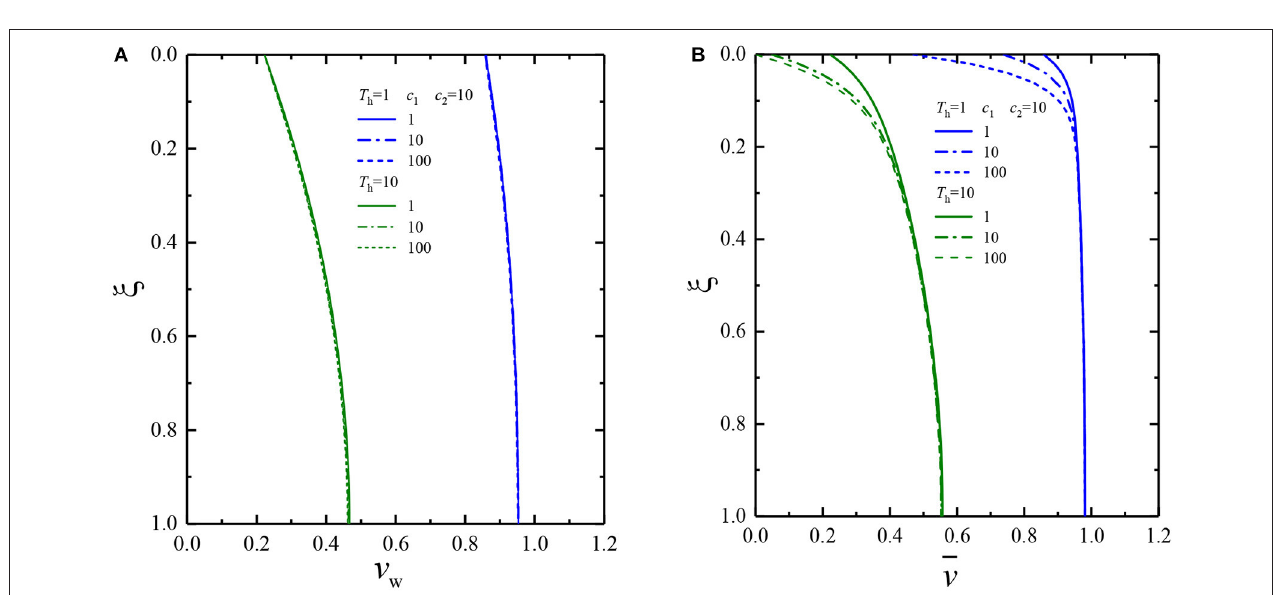
c 2 : (A) pore pressure in vertical drains, (B) average pore pressure in the soil layer. =